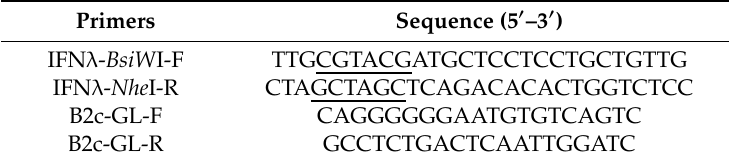
Table 1. Primers for construction and rescue of recombinant rabies viruses (RABVs) expressing murine IFN- λ